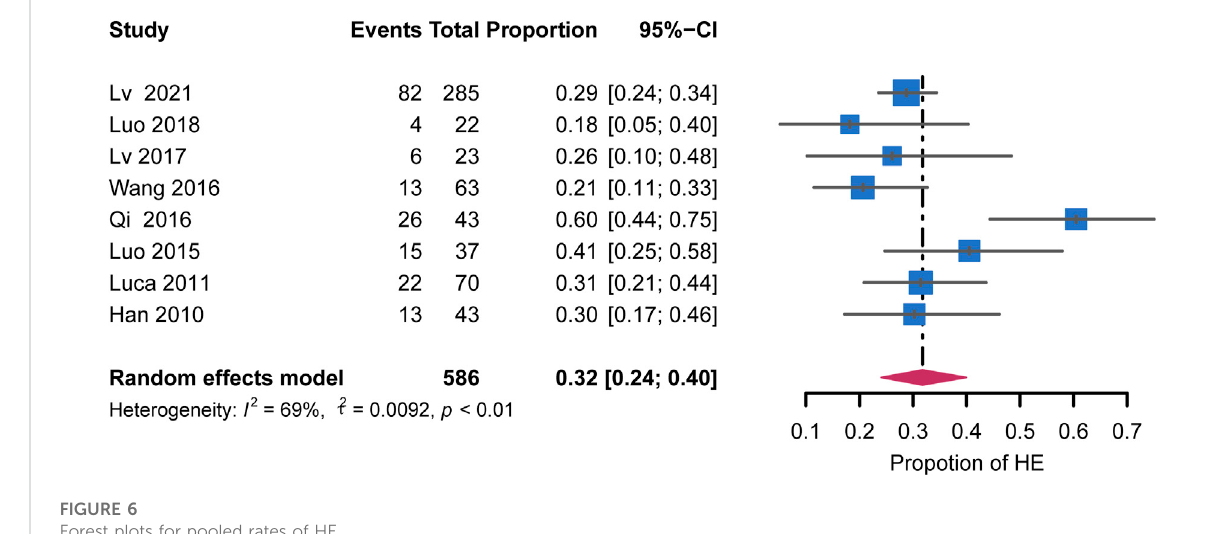
FIGURE 6 Forest plots for pooled rates of HE.